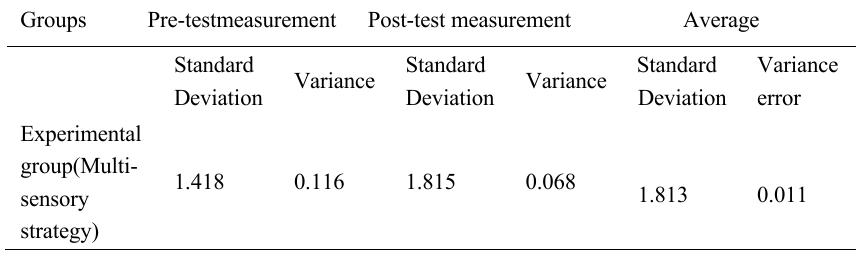
3 shows the differences between the mean scores of the experimental group of primary school learners with learning difficulties in the two measurements (pre and post) in their visual perception. The result is in favor of post-test with 1.815, while the average of the pre- measurement was appeared to be